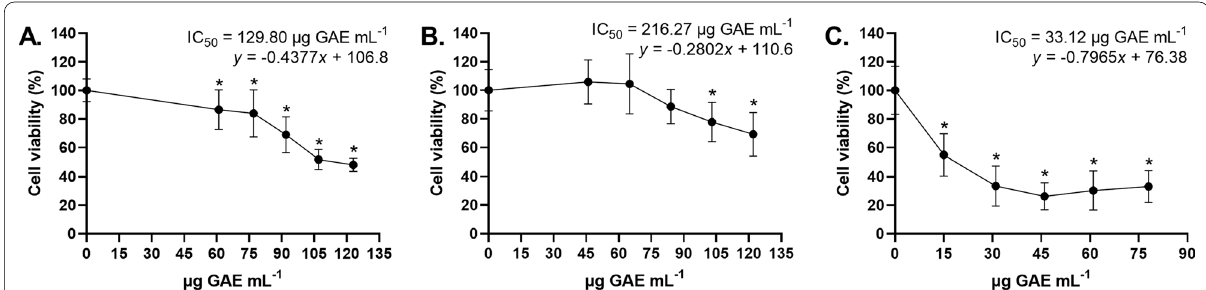
Fig. 3 Percentage (mean SD, n 3) cell viability (MTT assay) in NIH‑3T3 (murine skin fibroblasts), NCI‑H460 (human lung carcinoma cells), and ± = MCF7 (human breast adenocarcinoma) cells, treated with whole apple ( Malus domestica cv. Anna) extract (1 mg ml − 1 ) for 24 h. A . NIH‑3T3 (0, 61, 77, 92, 107, 123 μg GAE ml − 1 ). B. NCI‑H460 (0, 46, 65, 84, 102, 123 μg GAE ml − 1 ). (C) MCF7 (0, 15, 31, 46, 61, 77 μg GAE ml − 1 ). Statistical differences relative to the untreated controls were determined by one‑way ANOVA followed by a Dunnett´s post‑test (* p < 0.05) (Graph‑Pad Prism v.